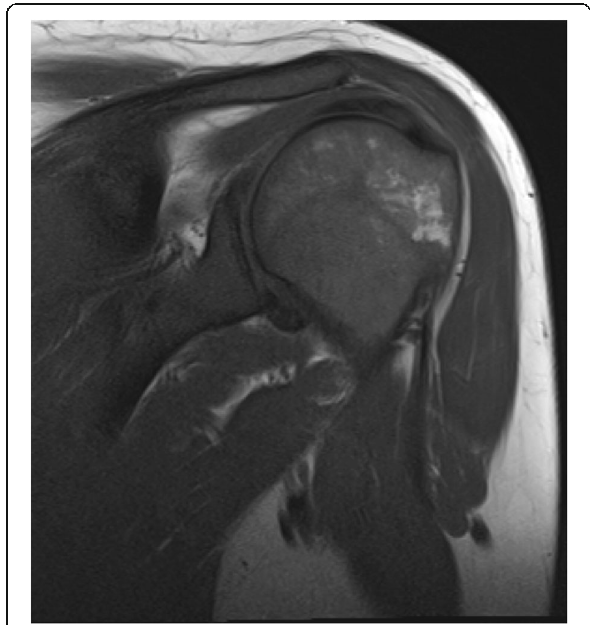
Fig. 8 Marrow infiltration in Gaucher disease. A 30-year-old female with type 1 Gaucher disease with shoulder pain. Coronal T1-weighted imaging demonstrates diffuse hypointense infiltration of the humerus including the proximal epiphysis compared to subcutaneous